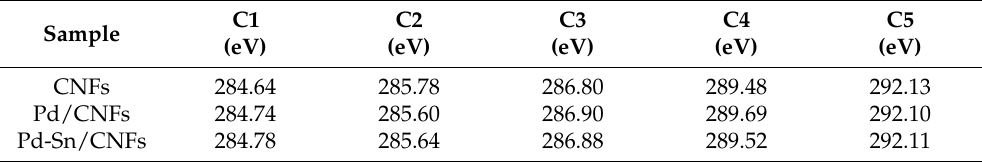
Table 4. The five components of the C 1s core level’s binding energies